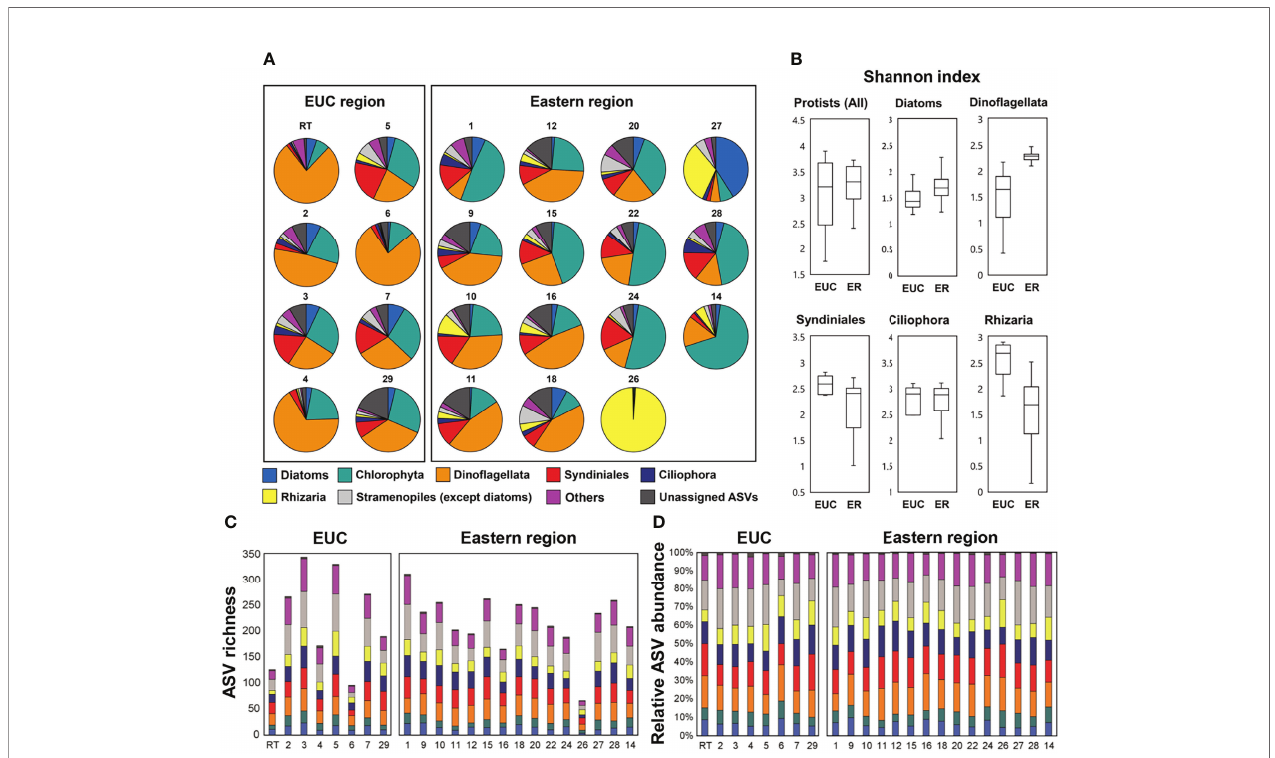
FIGURE 4 | 18S rRNA gene amplicon sequencing of higher ranked taxonomic groups of protistan communities at the sites within the Equatorial undercurrent upwelling (EUC) region and eastern region. (A) Taxonomic abundance based on read counts, (B) Box and whisker plots of the Shannon alpha diversity, (C) species richness and (D) relative abundance based on the number of